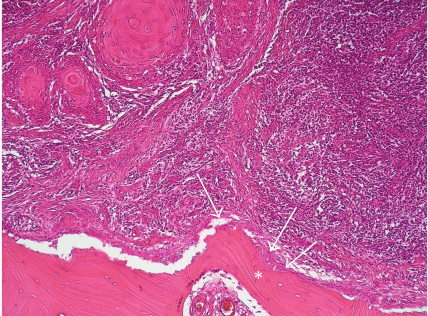
Figure 7: Case 2—histological view of the cross section specimen after Haematoxglin-Eosin staining. The arrows mark the arrosion of the bone ( ∗ ) by the tumor